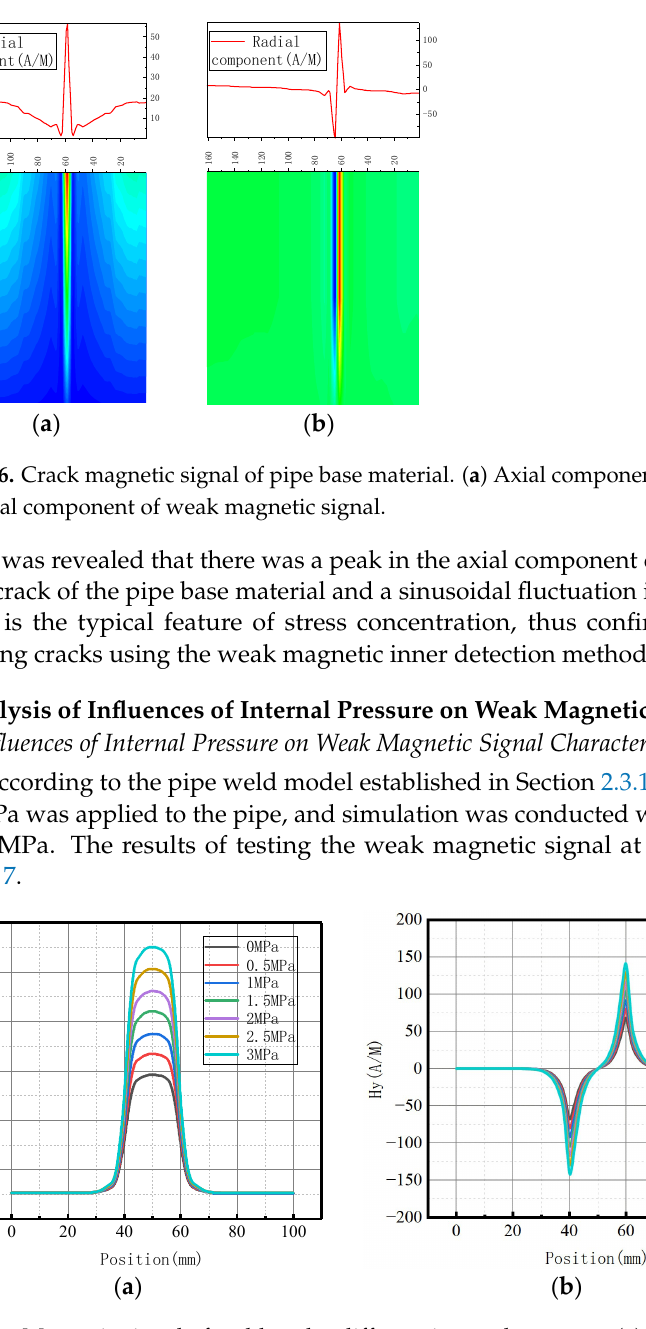
Figure 7. Magnetic signal of weld under different internal pressure. ( a ) Axial component of weak magnetic signal; ( b ) radial component of weak magnetic signal.